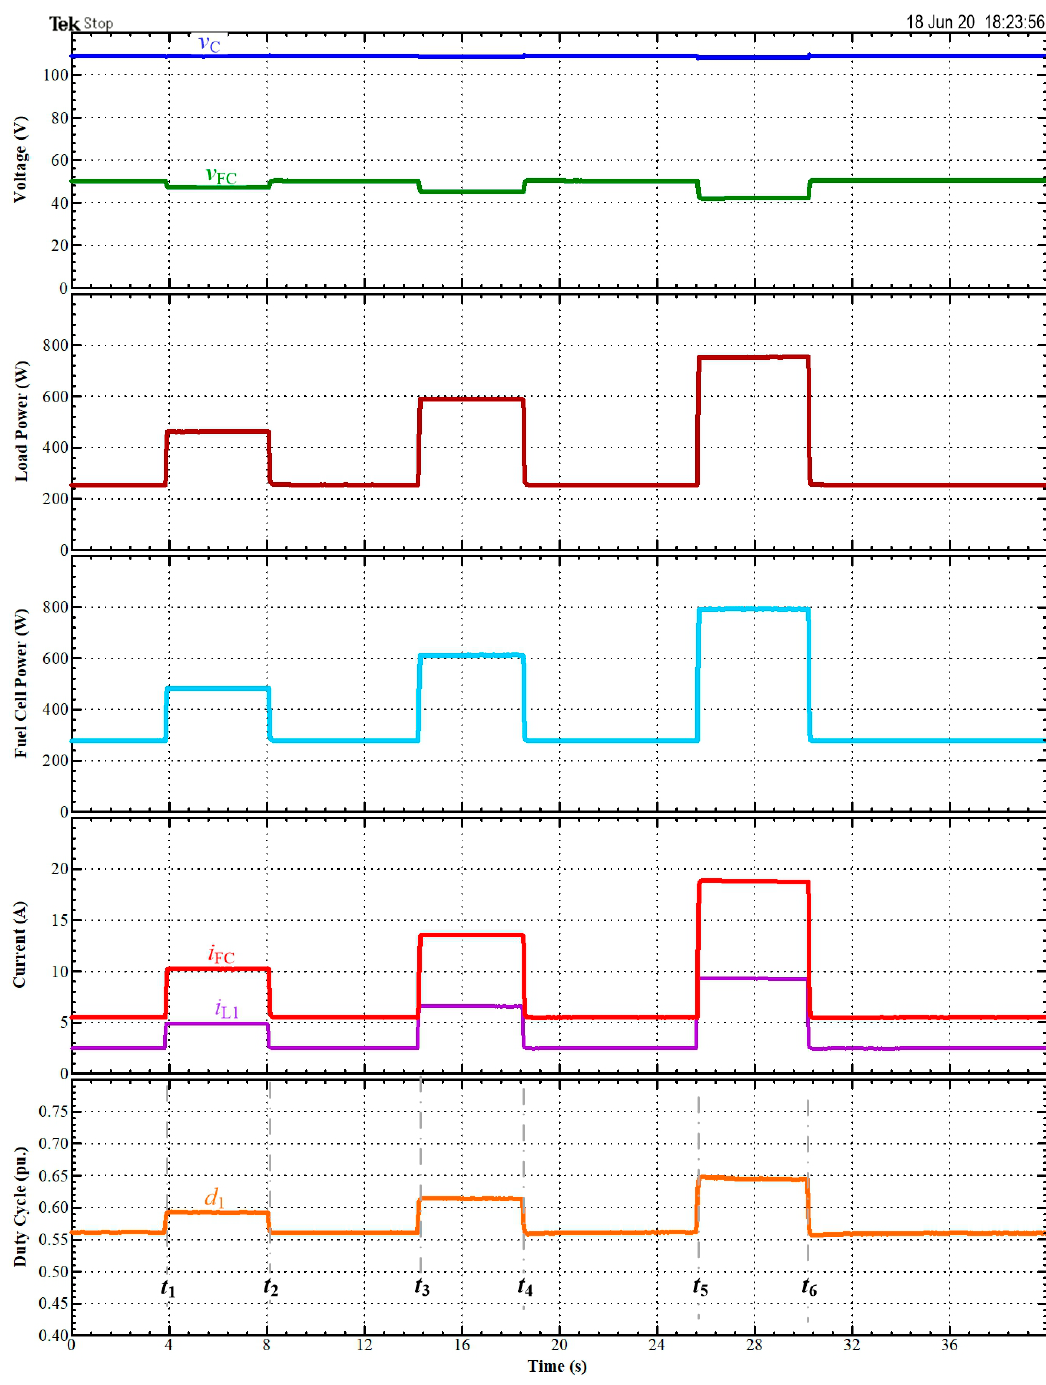
Figure 12. Experimental test bench results: FC converter response during the long load cycles.